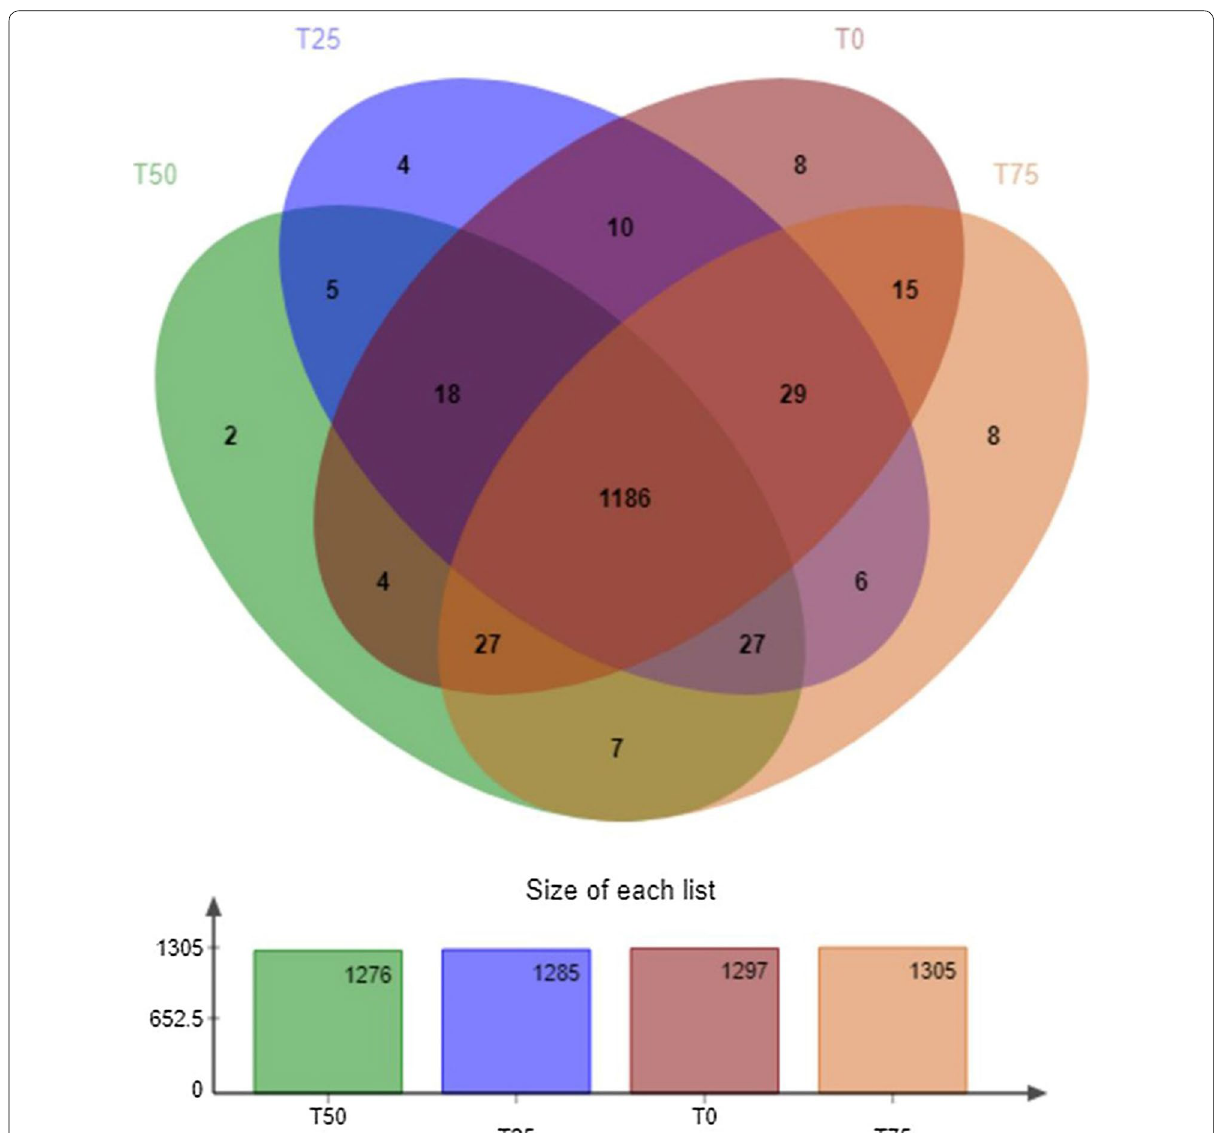
Fig. 1 Venn map of operational taxonomic units (OTU) in the four treatment. T0: BPS replaces 0% of WCS; T25: BPS replaces 25% of WCS; T50: BPS replaces 50% of WCS; T75: BPS replaces 75% of WCS. BPS, Broussonetia papyrifera silage; WCS, whole corn